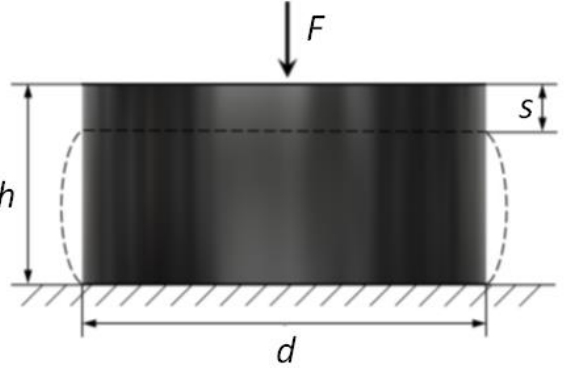
Figure 3. Shock absorber deflection under force F.